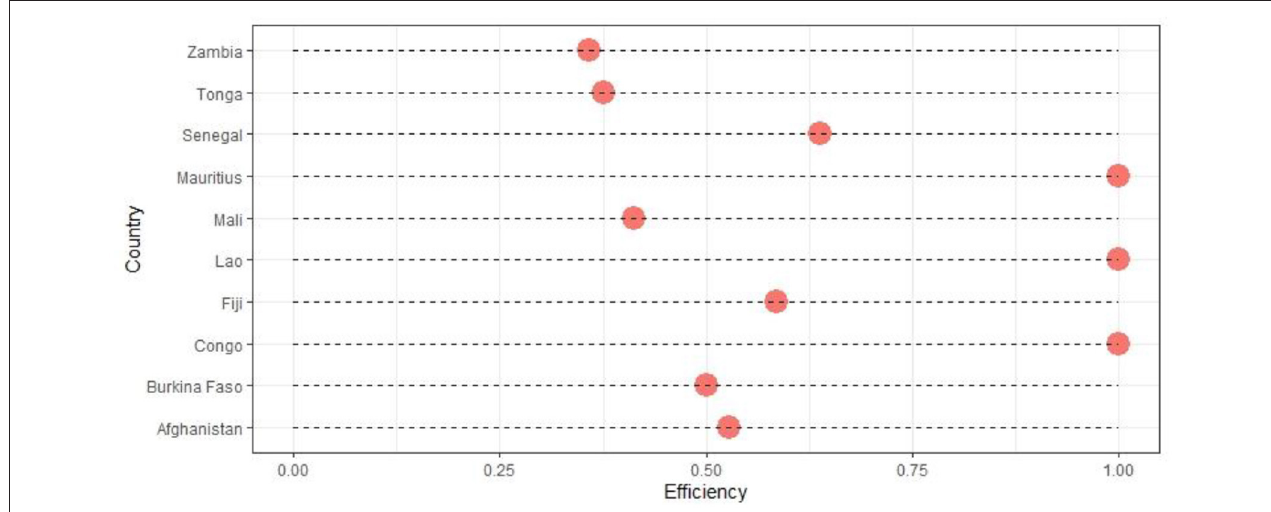
FIGURE 1 | DEA-BCC efficiency scores for Cluster 1-countries (The each red dot represents the efficiency score of the respective country. On a scale 0–1.0, higher score refers to better emission mitigaton